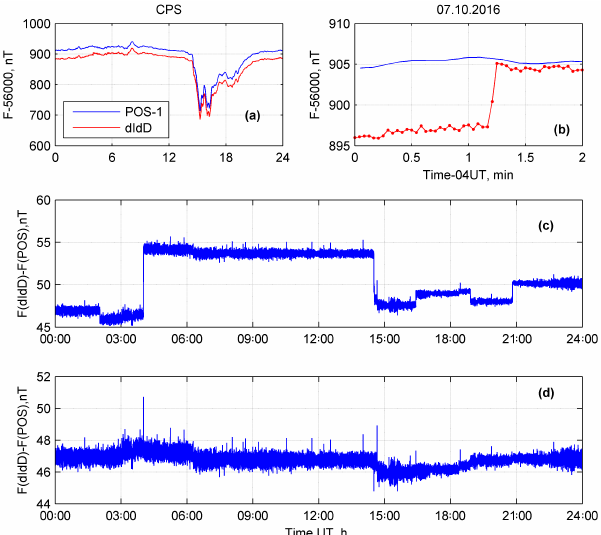
Figure 8. Noise caused by a vehicle driving near the magnetic pavil- ions at the Cape Schmidt observatory (in one direction and back). (a) d H (upper curve) and d D (lower curve) variations, recorded by MAGDAS magnetometer. (b) d Z (MAGDAS, upper curve), d F (POS-1, middle curve with dots) and d F (dIdD, lower curve). MAGDAS and dIdD magnetometers are located at a distance of about 30m from the